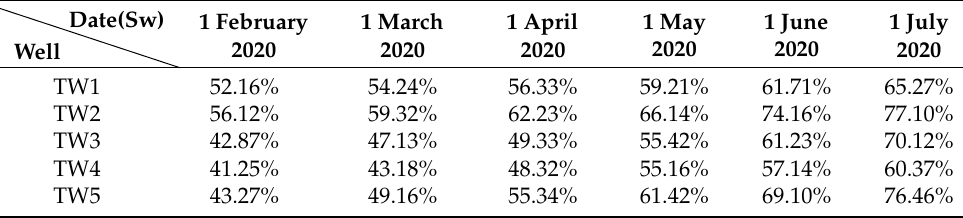
Table 3. Statistical table of water cut change of 5 verification wells in the initial 6 months.